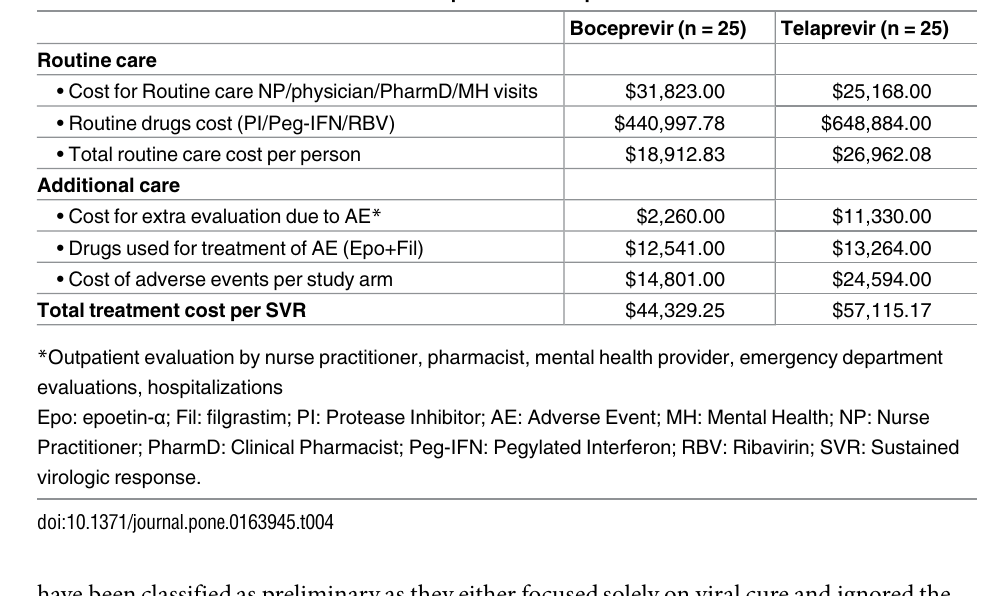
Table 4. Resource use associated with boceprevir and